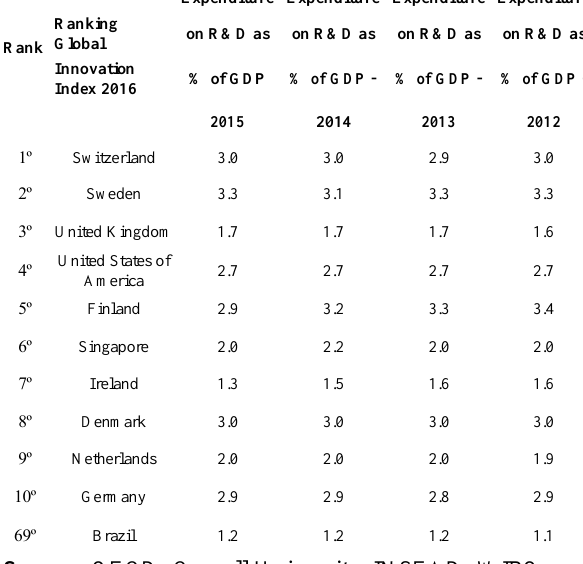
Table 1. Top 10 Innovative Countries and Brazil based